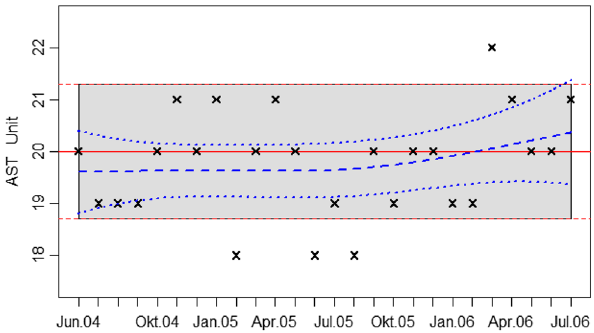
Figure 5: Example of a long-term drift. Crosses represent calculated monthly medians, the red line is the overall median. The dashed blue line is the fitted smooth curve of monthly medians with their confidence limits (dotted blue lines). Dashed red lines (limit of the grey zone) indicate the calculated permissible uncertainty of the overall median through Equations (3) – (12) in ref. [75]. Differences of monthly medians set in grey zone can be explained by computed measurement uncertainty. The permissible uncertainty is quanti fi ed by the permissible analytical standard deviation derived from the empirical biological variation [77]. The Figure is taken from ref.